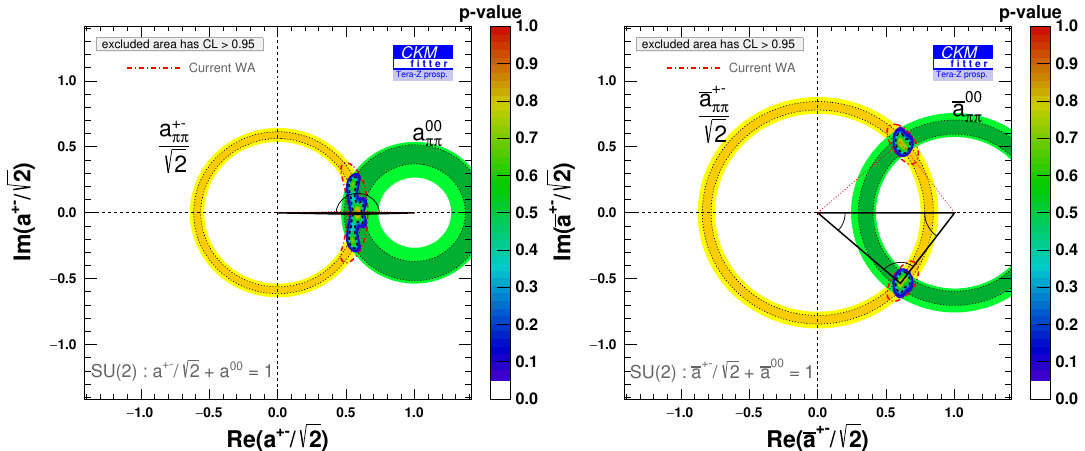
¯ B 0 , B − modes on the right) = 0 . 950 ± 0 . 018 . CP